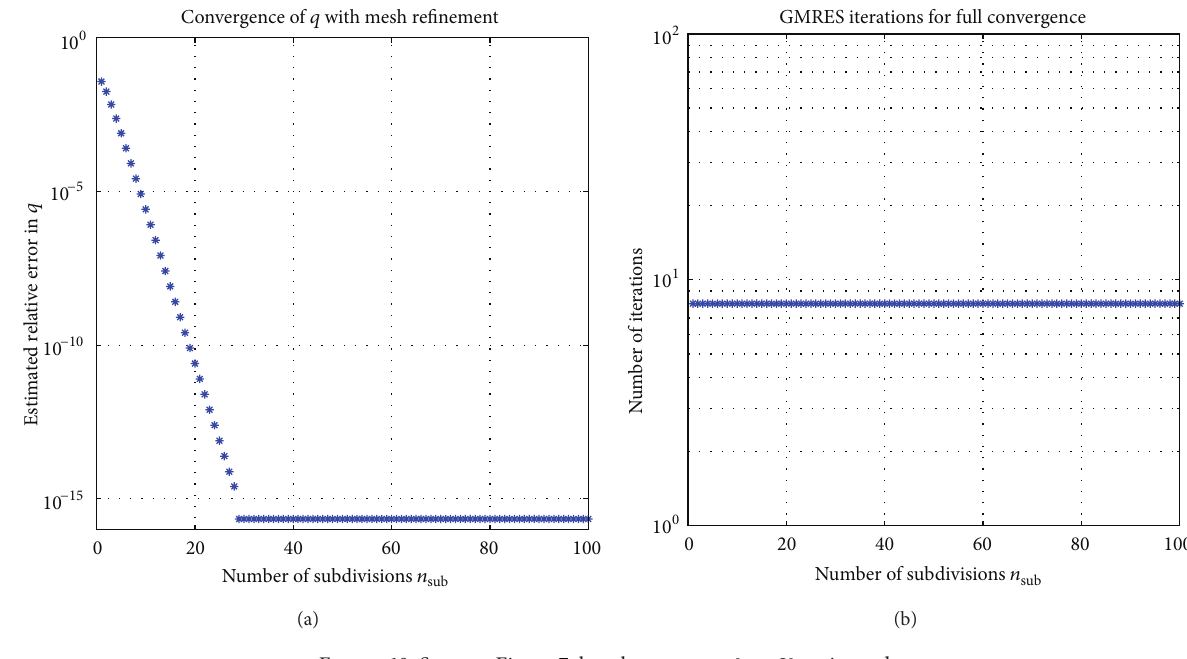
Figure 10: Same as Figure 7, but the program demo8b.m is